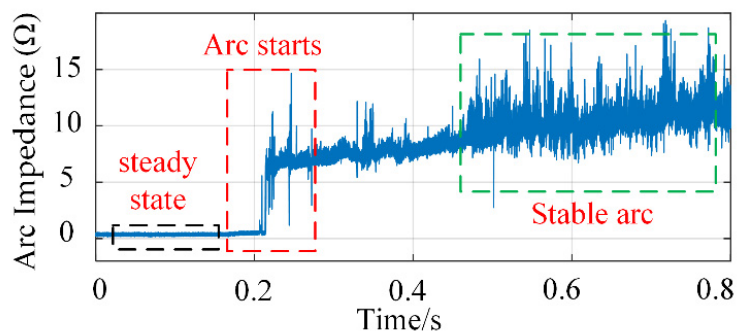
Figure 11. Arc contact resistance waveform.